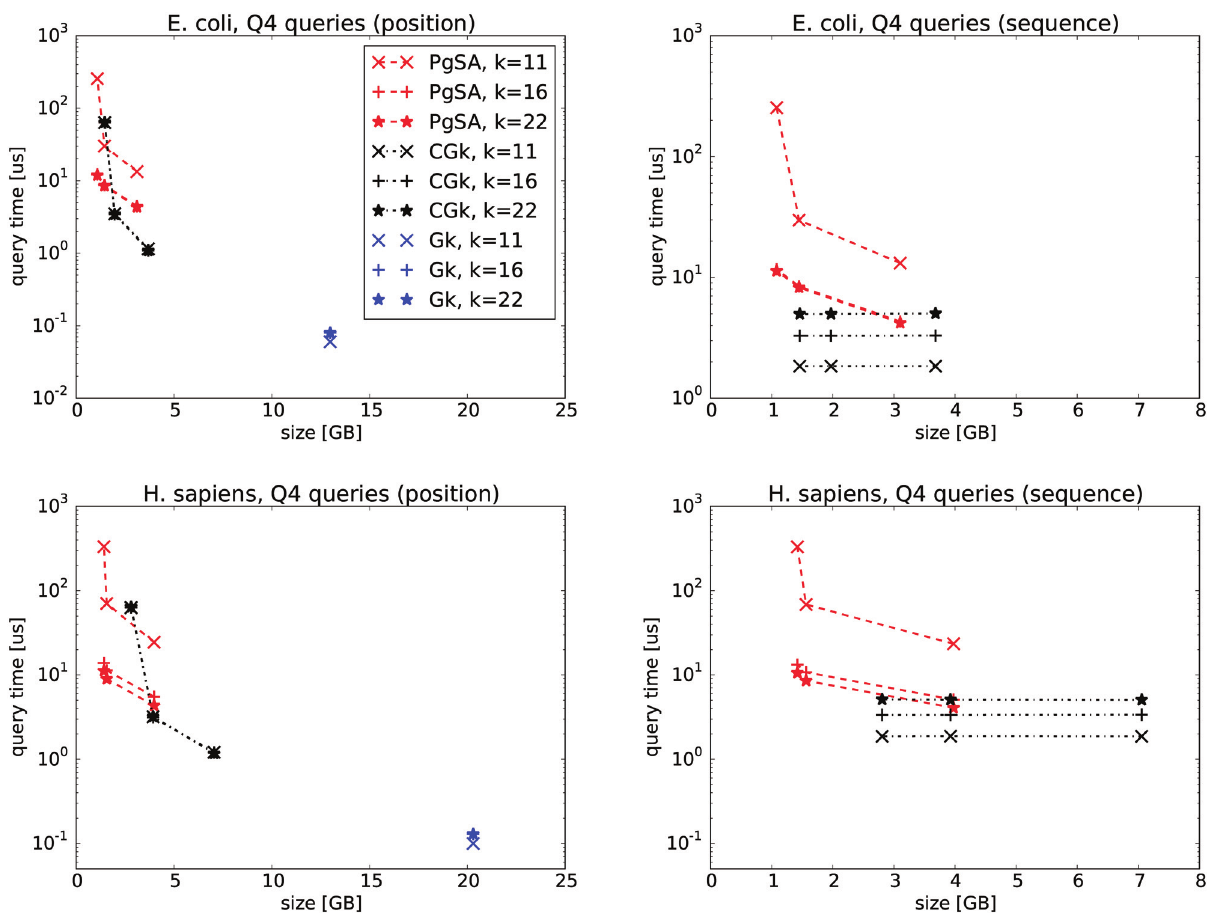
Fig 5. Q 4 query results on E. coli (top row) and H. sapiens (bottom row) datasets. The three points in PgSA series correspond to sparsity s = 6 for the leftmost point, s = 3 (E. coli) or s = 4 (H. sapiens) for the middle point and s = 1 for the rightmost point. The three points in CGk series correspond to sampling rates sr of 512, 25 and 6 (E. coli), and 512, 22 and 6 (H. sapiens), respectively. On the left figures the query is given as a position in the read list, while on the right ones as a string.